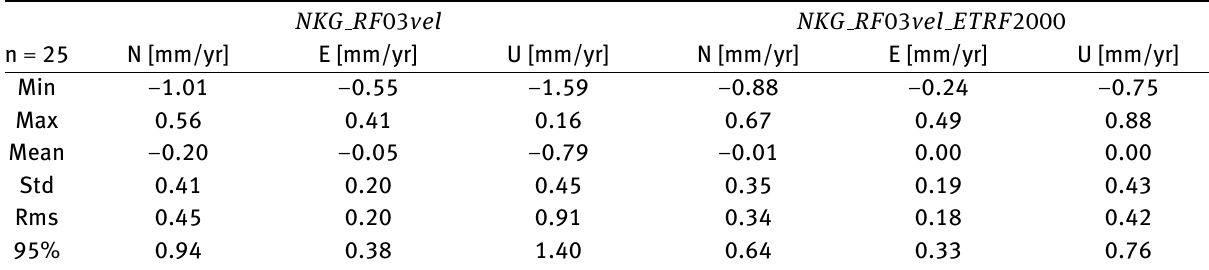
Table 2: Statistics of the velocity differences: ETRF2000 velocities of the EPNC1785 minus NKG RF 03 vel and NKG RF 03 vel ETRF 2000 (only stations in land uplift area considered in the statistics).